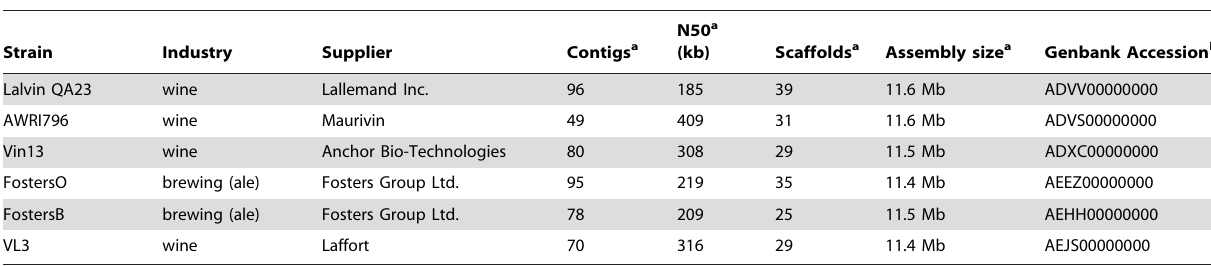
Table 1. Strains sequenced in this study.